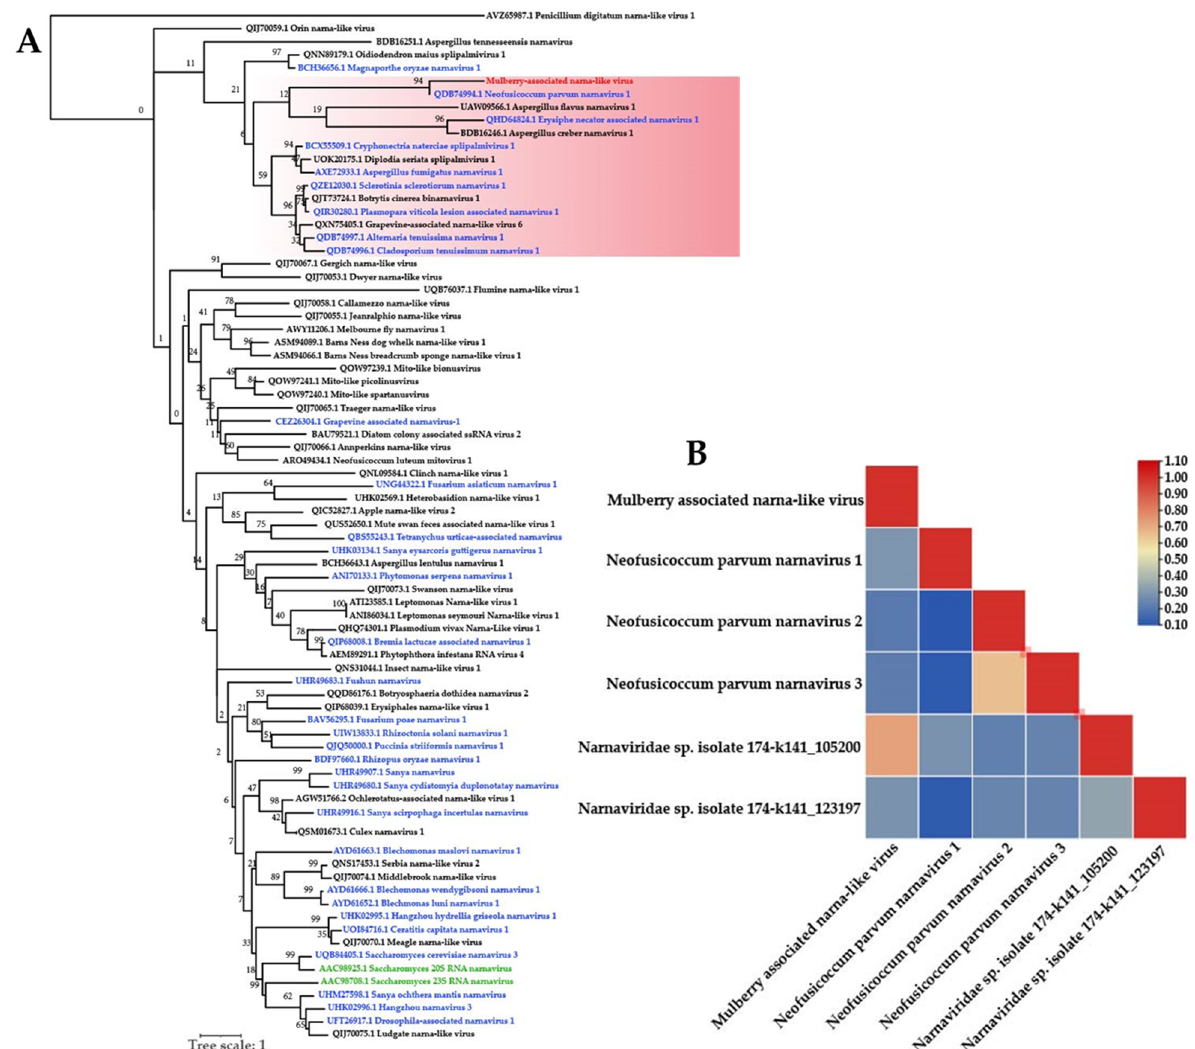
Figure 5. Phylogenetic trees of ( A ) RdRp proteins constructed for representative members of the family Narnaviridae (43 unclassified narnaviridaes; 32 unclassified narnaviruses; 2 narnaviruses). ( B ) The pairwise identity plots of the RNA-dependent RNA polymerase amino acid sequences aligned by ClustalW and displayed by sequence demarcation using TBtools software. The trees were constructed using the maximum likelihood method, and the statistical significance of the branches was evaluated by bootstrap analysis (1000 replicates). Newly discovered viruses are marked in red, unclassified narnaviridaes in black, unclassified narnaviruses in bule, and narnaviruses in green. Relationship: pink background.